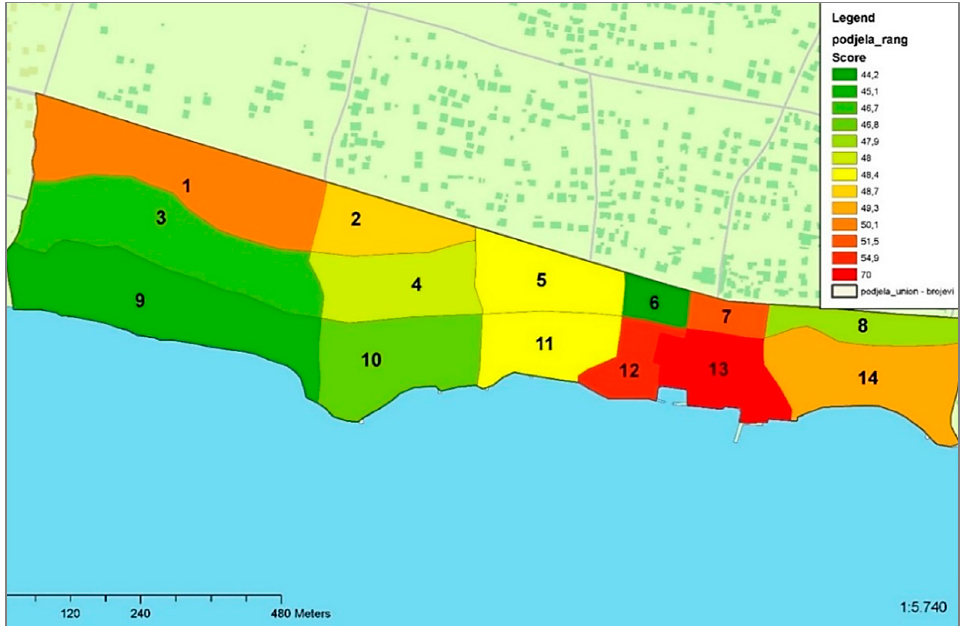
Figure 13. Seismic risk assessment for homogenous zones (green represents low risk, red represents high risk).